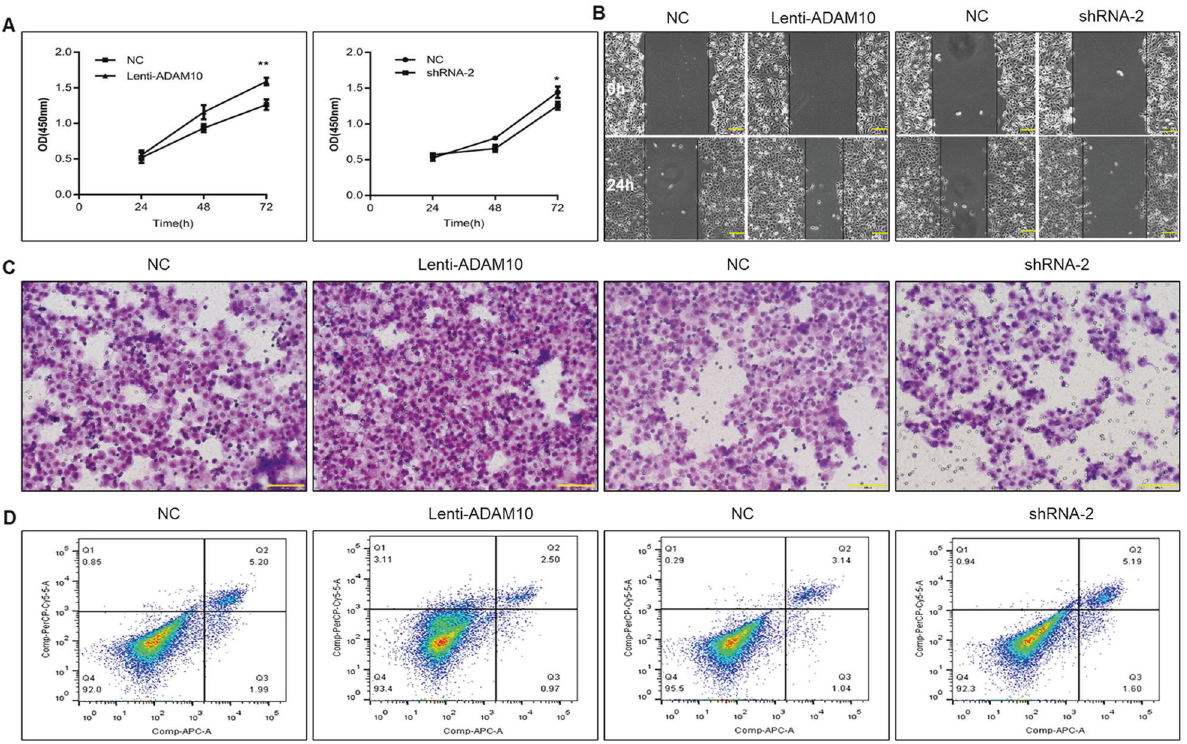
Fig. 2 ADAM10 exerts pro-tumor effect in vitro. A Effect of ADAM10 on the proliferation of DU145 cells, Lenti-ADAM10 vs NC, ** P < 0.01, shRNA-2 vs NC, * P < 0.05. B The effect of ADAM10 on the migration ability of DU145 cells was detected by scratch healing experiment, and the scratch healing rate was calculated, Lenti-ADAM10 vs NC, ** P < 0.01, shRNA-2 vs NC, *** P < 0.001, Scale bar, 100 µm. C Trans-well assay was used to detect the effect of ADAM10 on the invasive ability of DU145 cells, and the number of lower chamber cells was counted and compared.Lenti-ADAM10 vs NC, *** P < 0.01, shRNA-2 vs NC, *** P < 0.001, Scale bar, 100 µm. D Effect of ADAM10 on apoptosis of DU145 cells was detected by fl ow cytometry, Lenti-ADAM10 vs NC, ** P < 0.01, shRNA-2 vs NC, *** P <